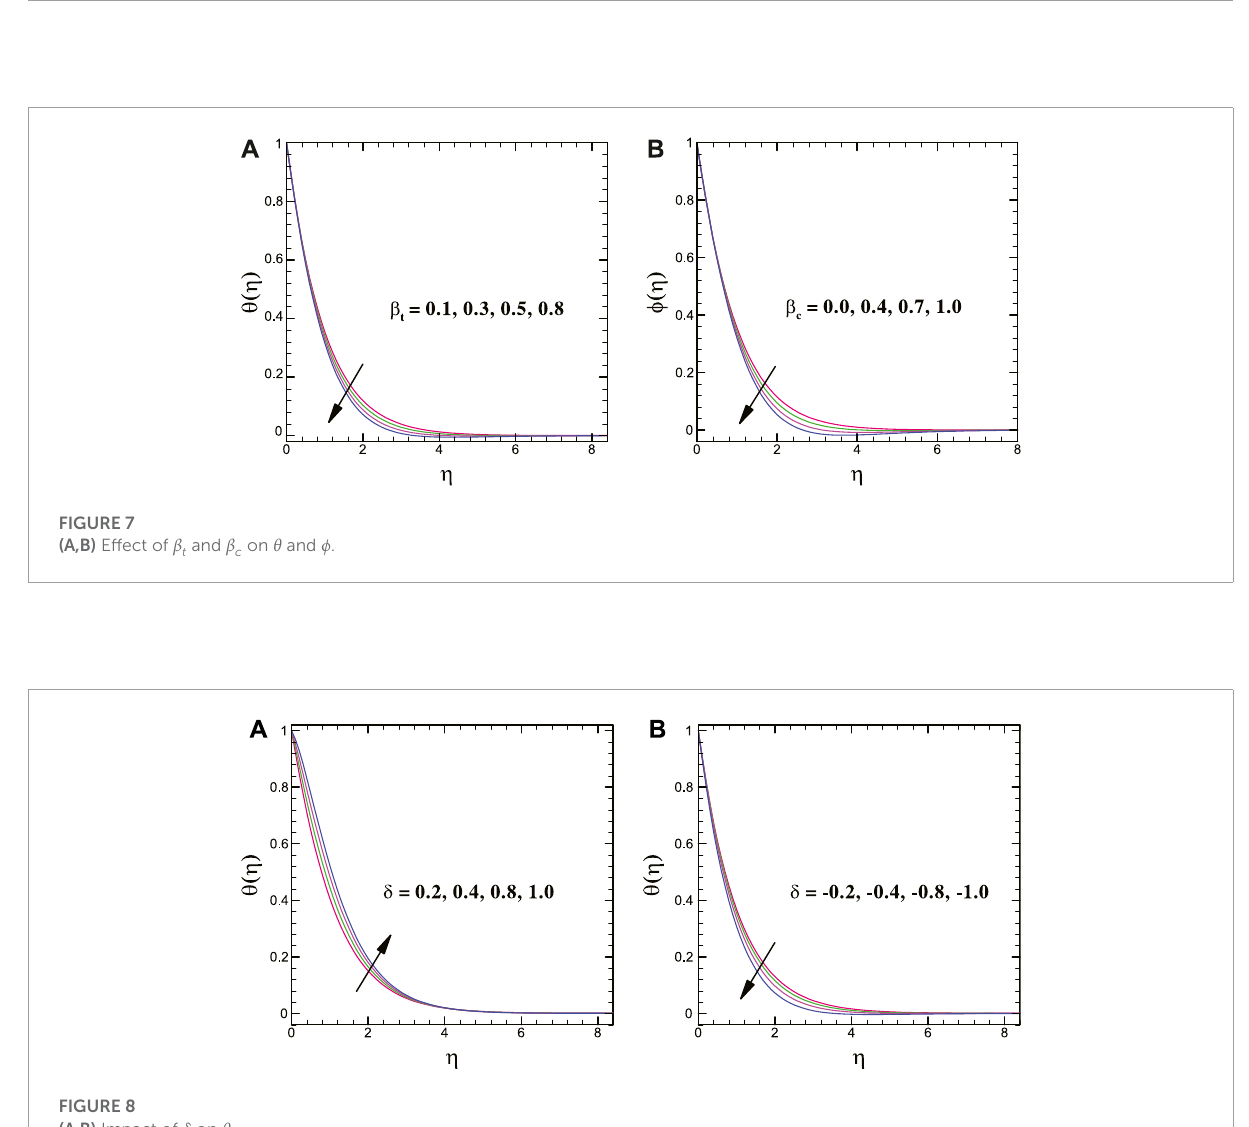
FIGURE 8 (A,B) Impact of δ on θ